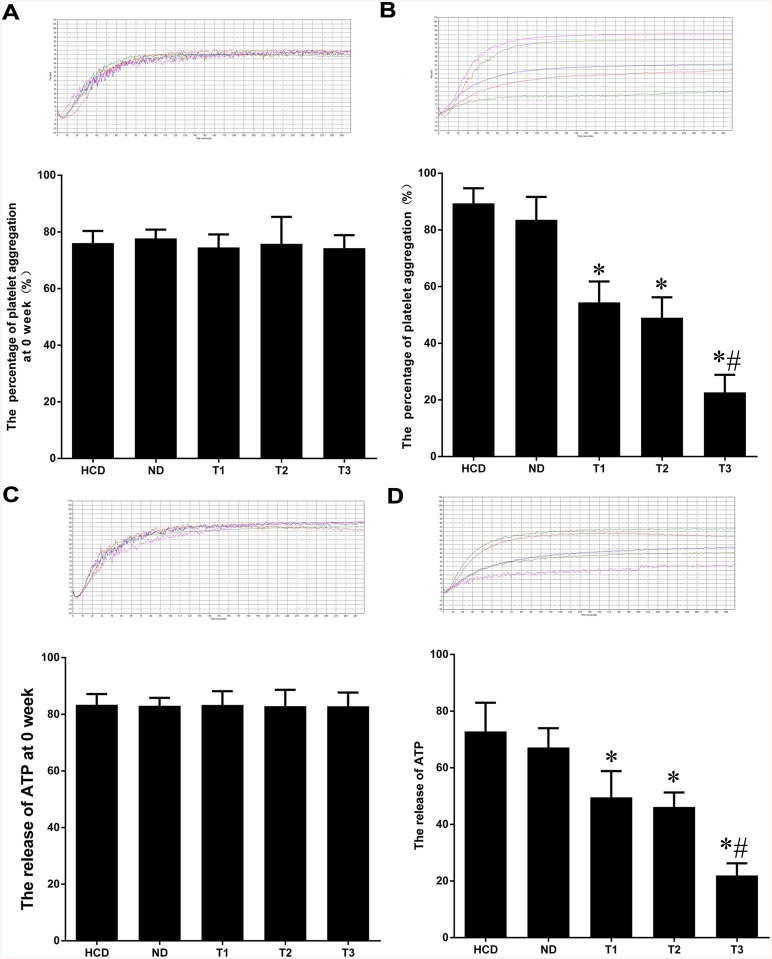
Representative experiments for platelet aggregation (A, 0 weeks; B, 16 weeks) and ATP release (C, 0 weeks; D, 16 weeks).At baseline, platelet activity showed no significant difference between groups. After 16 weeks, the maximal percentage of platelet aggregation and ATP release between each ticagrelor group and HCD group induced by collagen (5 μg/ml) was different (P<0.01), but there was no difference between the T1 (ticagrelor 25 mg/kg/d) and T2 (ticagrelor 50 mg/kg/d) groups. *P<0.01 vs. HCD. #P<0.01 vs. T1 and T2.